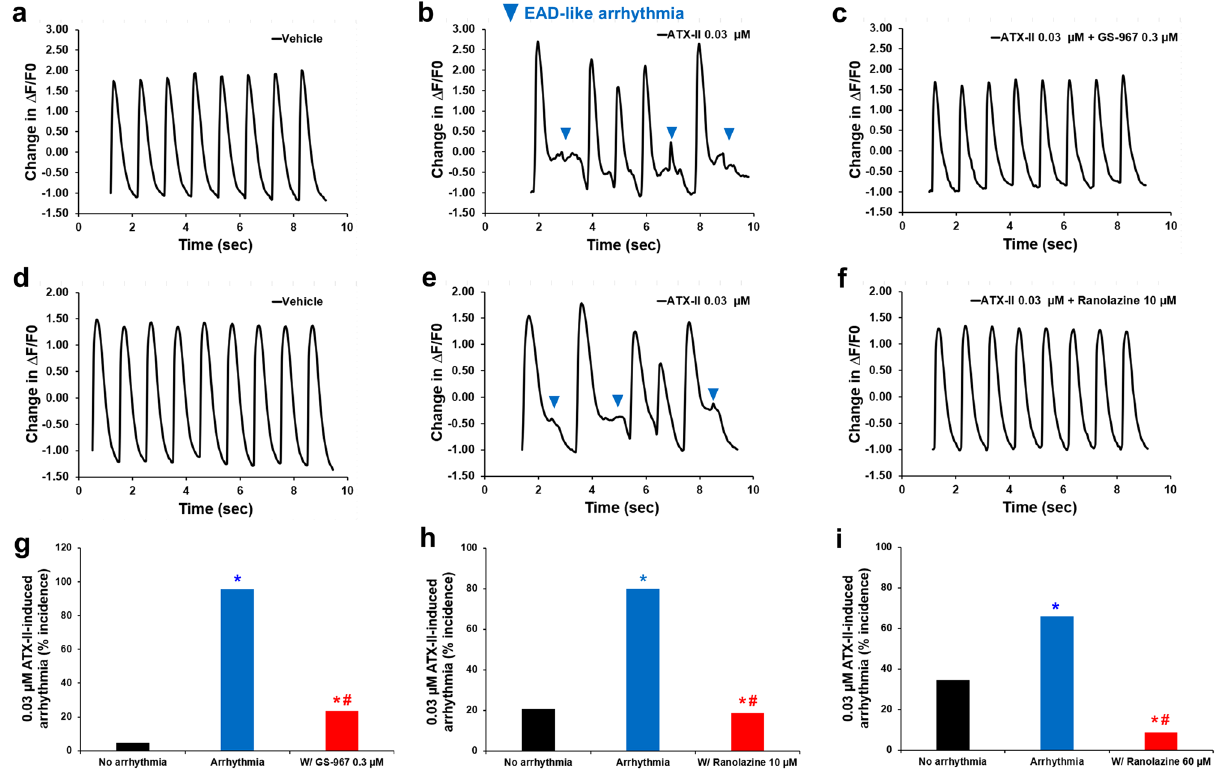
Figure 5. Effects of GS-967 and ranolazine on human ventricular Ca 2+ transient in condition mimicking LQTS3. ( a – c ) and ( d – f ) show typical Ca 2+ transients recorded from ventricular cells at a pacing of 1 Hz in the presence of vehicle control ( a and d ) and after exposure to 0.03 µM ATX-II alone ( b and e ) or in combination with 0.3 µM GS-967 ( c ) and 10 µM ranolazine ( f ). ( g ), ( h ) and ( i ) show mean % incidence in ATX-II-induced arrhythmia induced by addition of ATX-II alone or in the presence of GS-967 ( g , n = 45 cells) or ranolazine (10 µM, h , n = 58 cells; 60 µM, i , n = 35 cells) at 1 Hz. *,* p < 0.05 versus values from vehicle control. # p < 0.05 versus values from ATX-II. MetaMorph analysis software (Molecular Devices, CA, USA, www. molec ulard evices. com) and a validated custom written MatLab program (The MathWorks Inc., MA, USA, www. mathw orks. com) were used to generate the representative Ca 2+